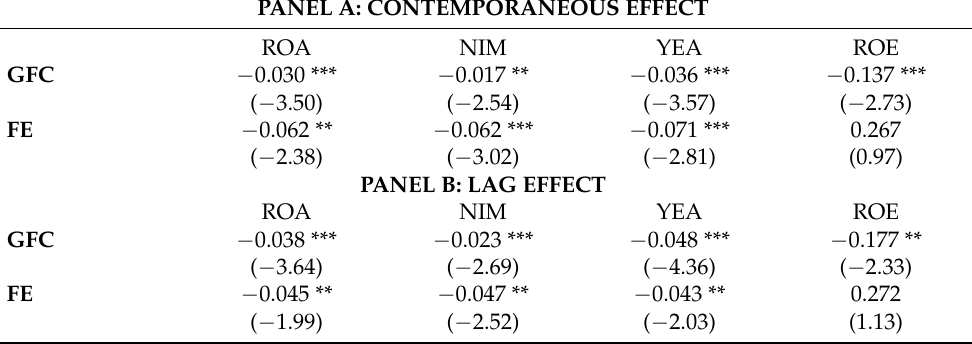
Table 9. Robustness tests.